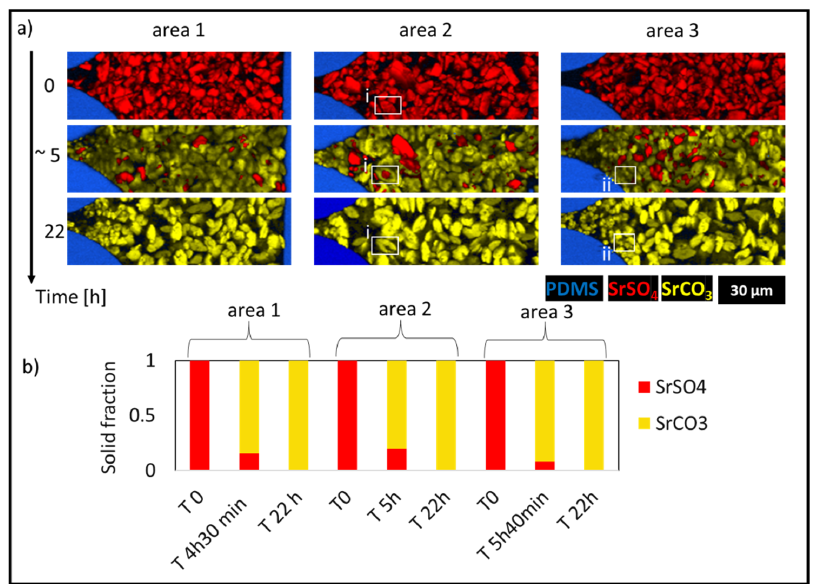
Figure 4. ( a ) 2D Raman images capturing the mineralogical changes in the monitored areas with time with interface coupled dissolution and precipitation (ICDP) with the formation of encrustation pseudomorphs (i) and recrystallization of the fine grain strontianite (Oswald ripening, (ii)); ( b ) mole fractions of the initial celestine converted to strontianite.